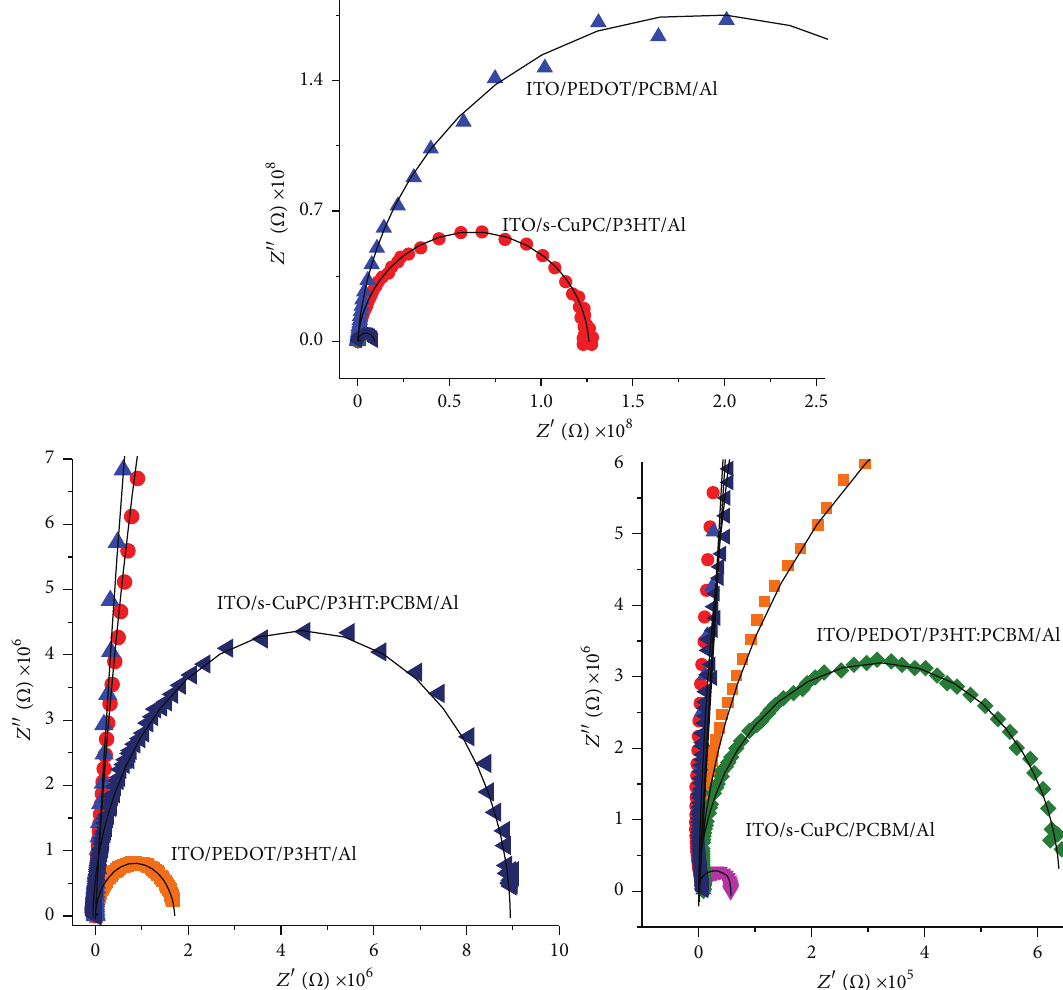
Figure 3: Nyquist curves obtained from IS measurements performed on nine different ITO/HTL/active layer/Al structures. Symbol curves represent experimental data and solid curves represent the theoretical fit.